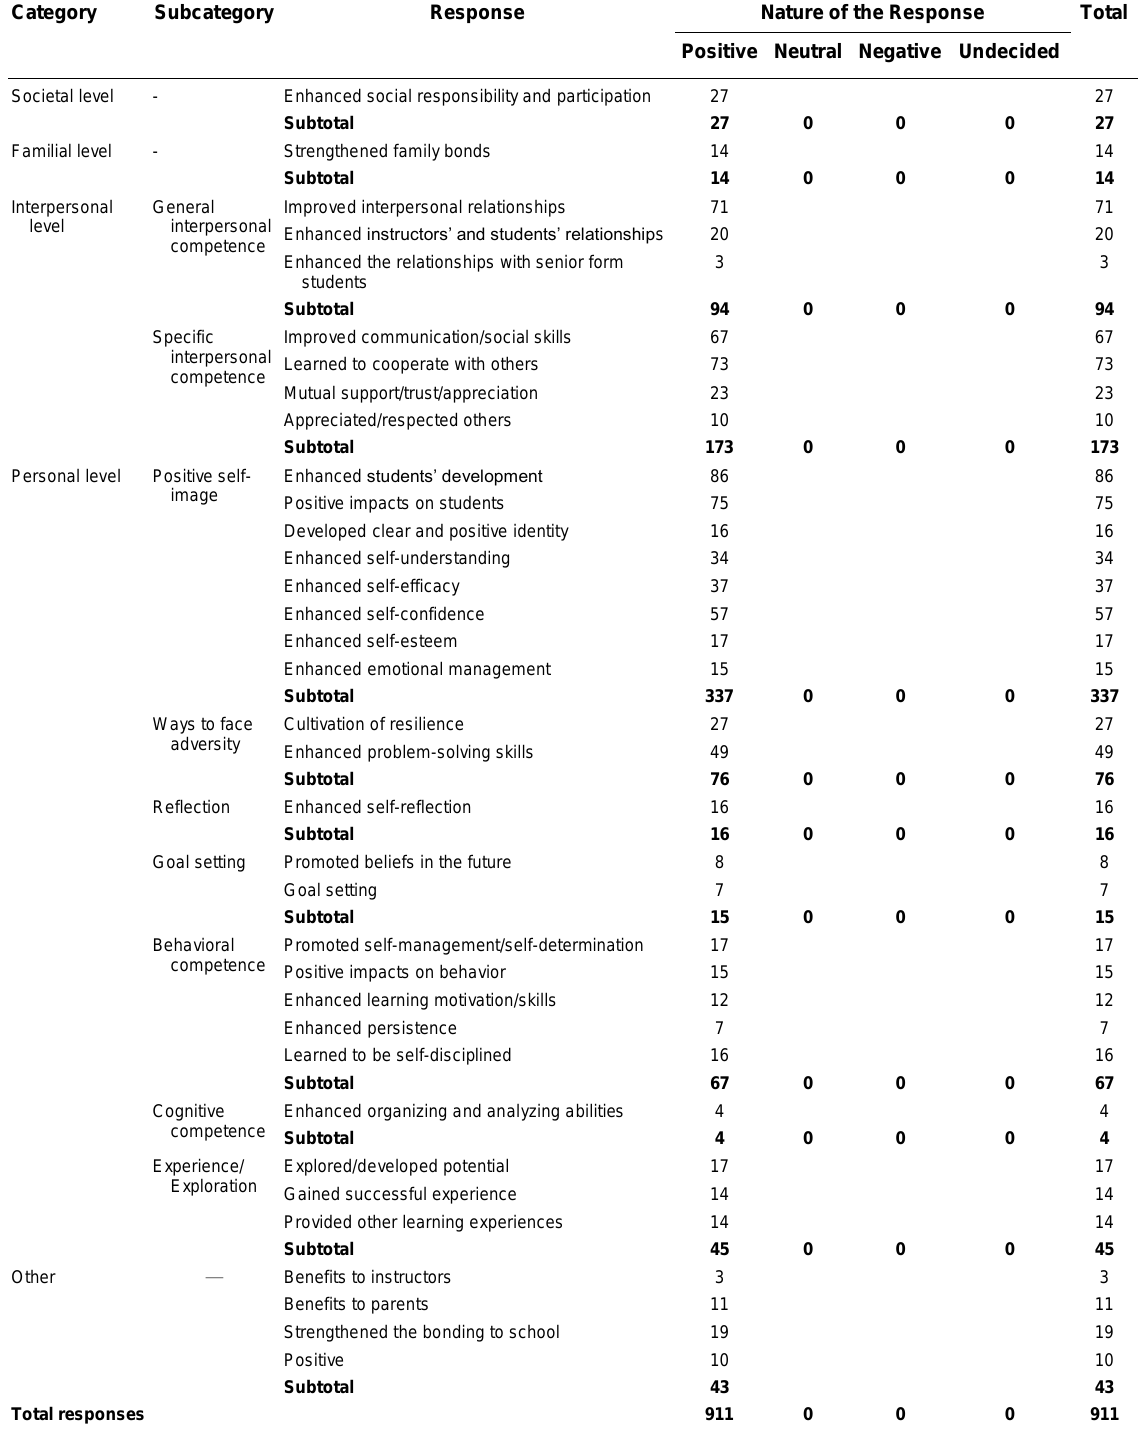
Responses to Perceived Program